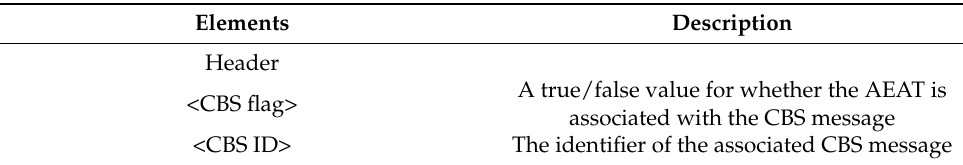
Table 3. The additional elements of the modified